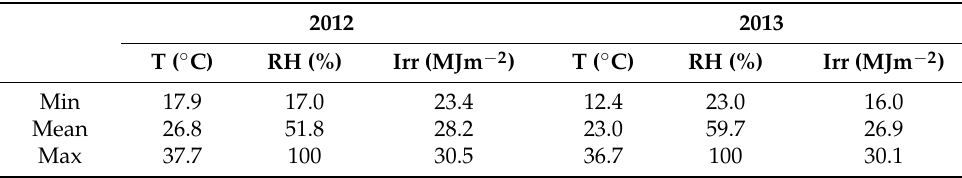
Table 1. Statistical values of air temperature (T), air relative humidity (RH) and solar irradiation (Irr) calculated from values measured outside the greenhouse during the two trials (from 21 June to 8 July 2012–21 June to 8 July